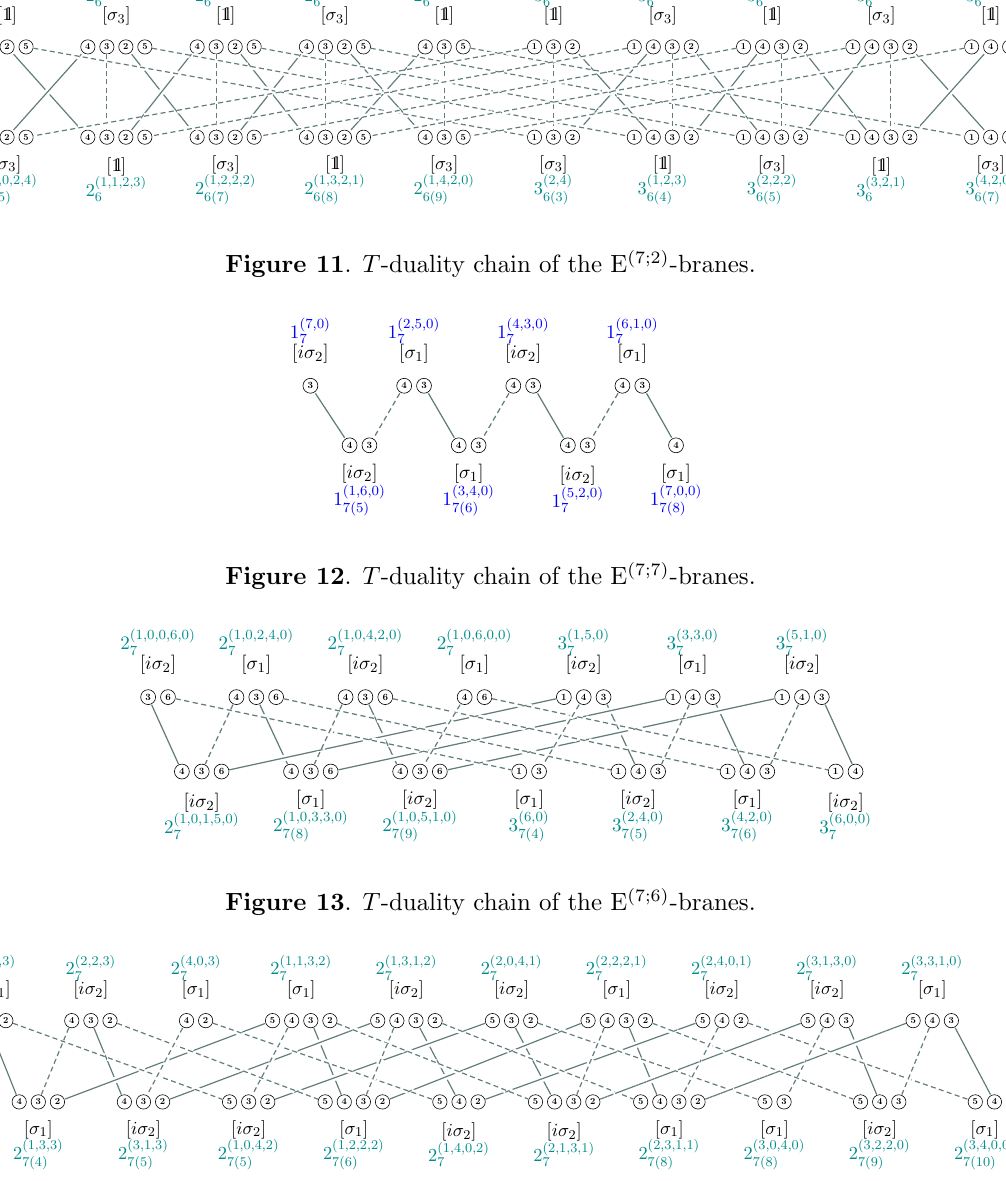
Figure 14 . T -duality chain of the E (7;4) -branes.